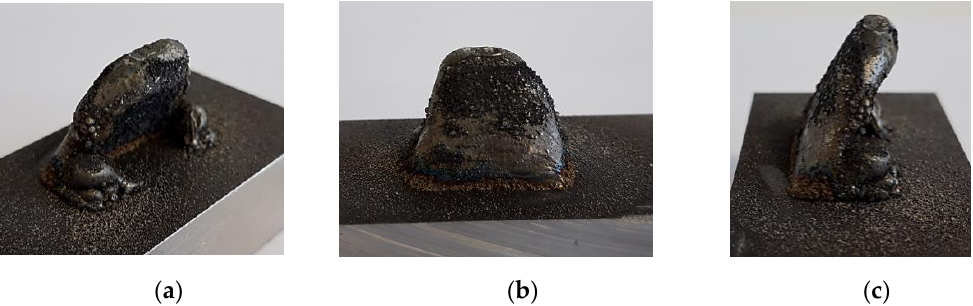
Figure 16. Wall with a length of 20 mm deposited employing continuous coaxial nozzle with Strategy B at 30°. ( a ) wall; ( b ) back view; ( c ) profile view.